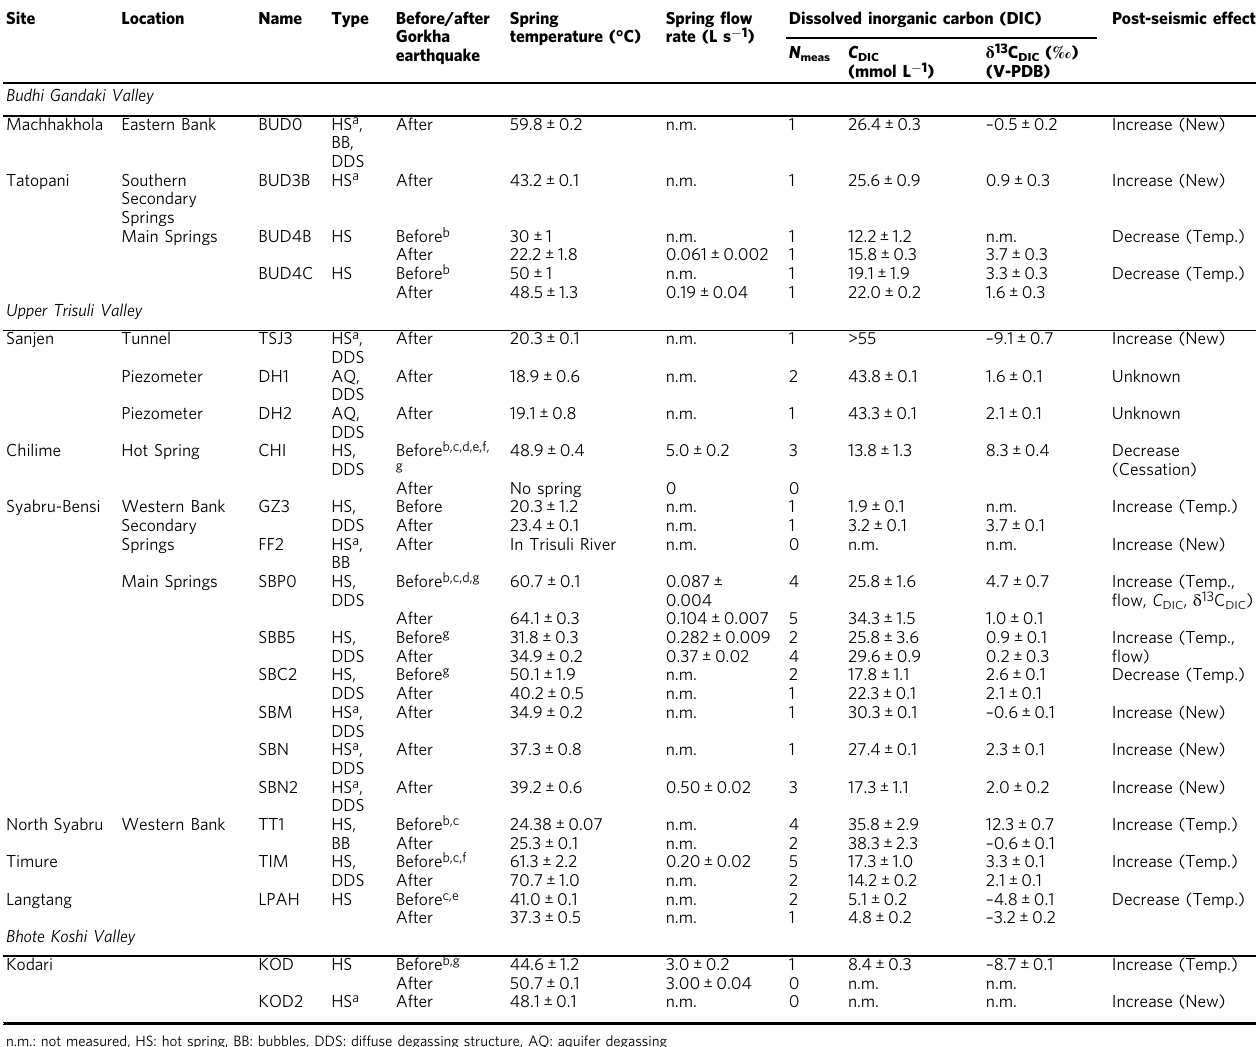
Table 2 Post-seismic effects on the hot springs at nine hydrothermal sites in Central Nepal. Data of temperature, fl ow rate, and dissolved inorganic carbon concentration and isotopic ratio of hot springs are compiled before and after the Gorkha